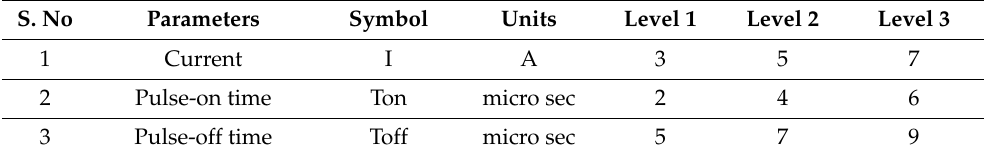
Table 1. Process parameters and their levels.